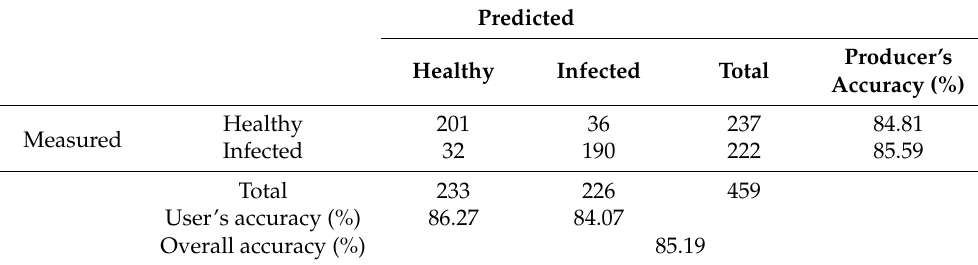
Table 8. Results (confusion matrix) of Method-STF.